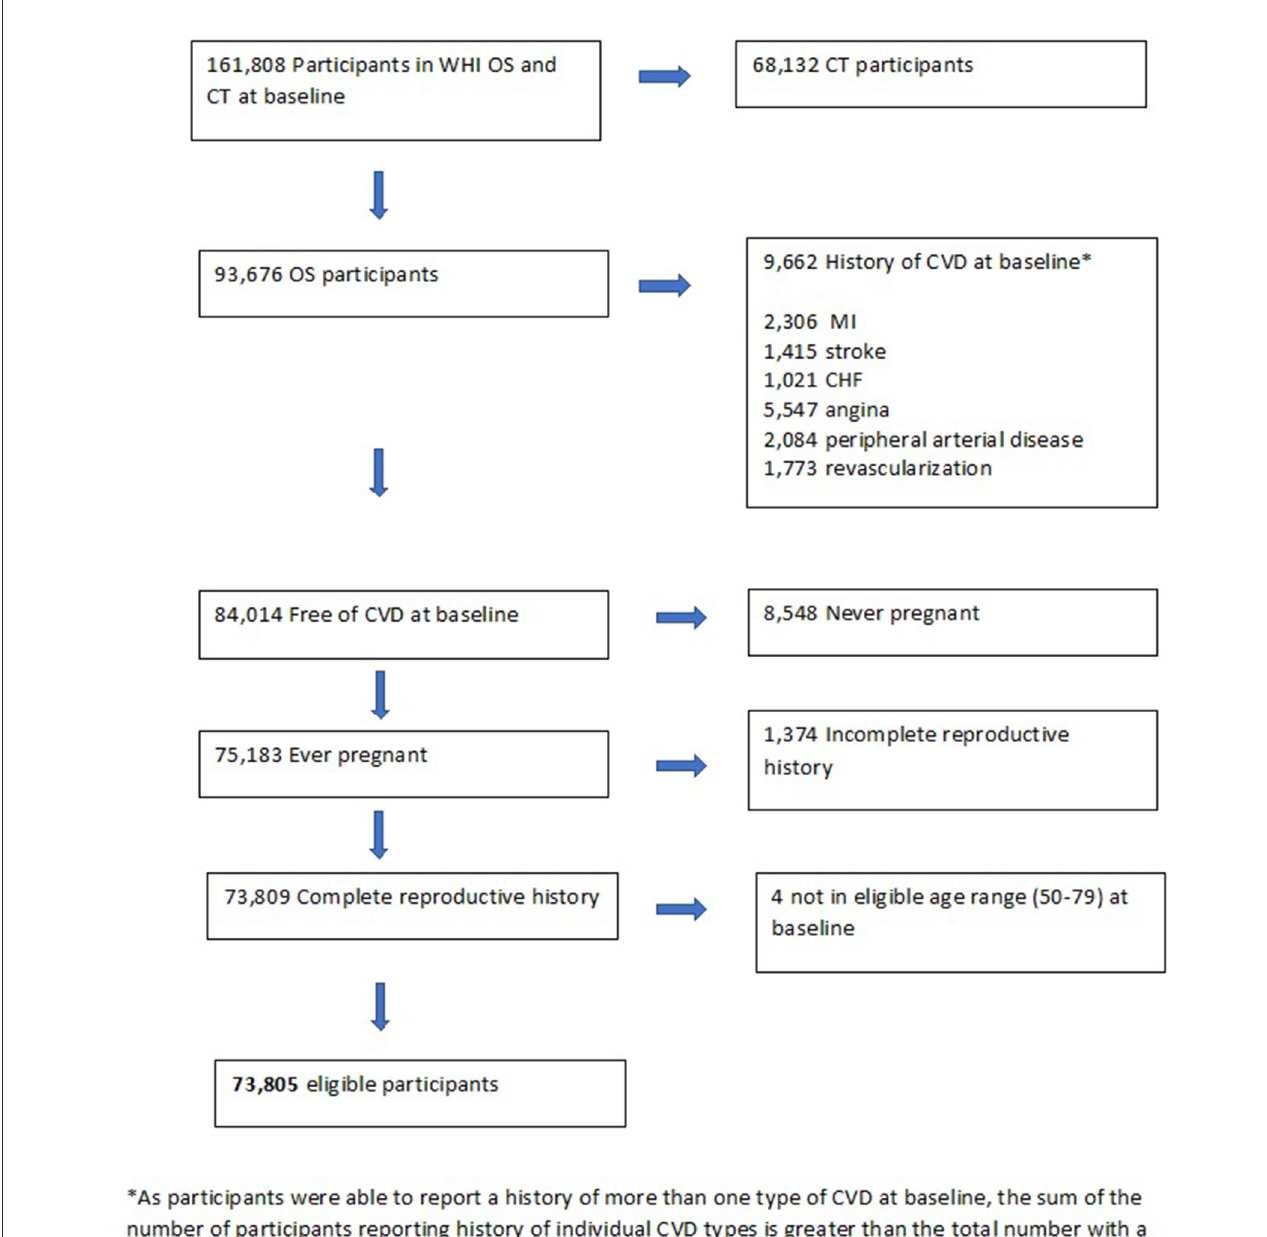
FIGURE1 Identification of WHI participants eligible for inclusion in the current study.